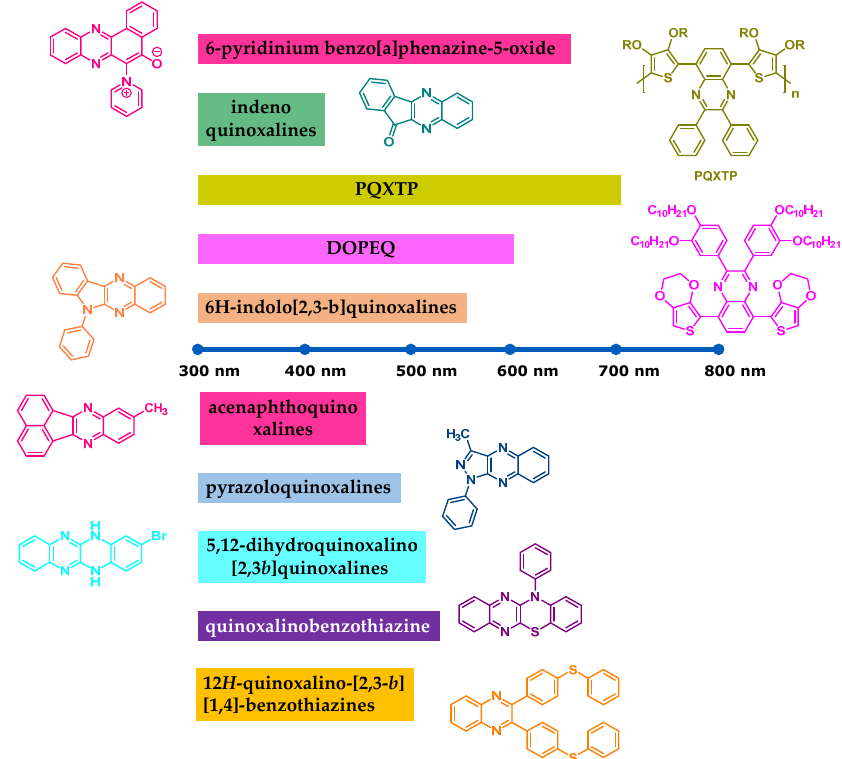
Figure 42. Absorption range of the different families of dyes depicted in this review.